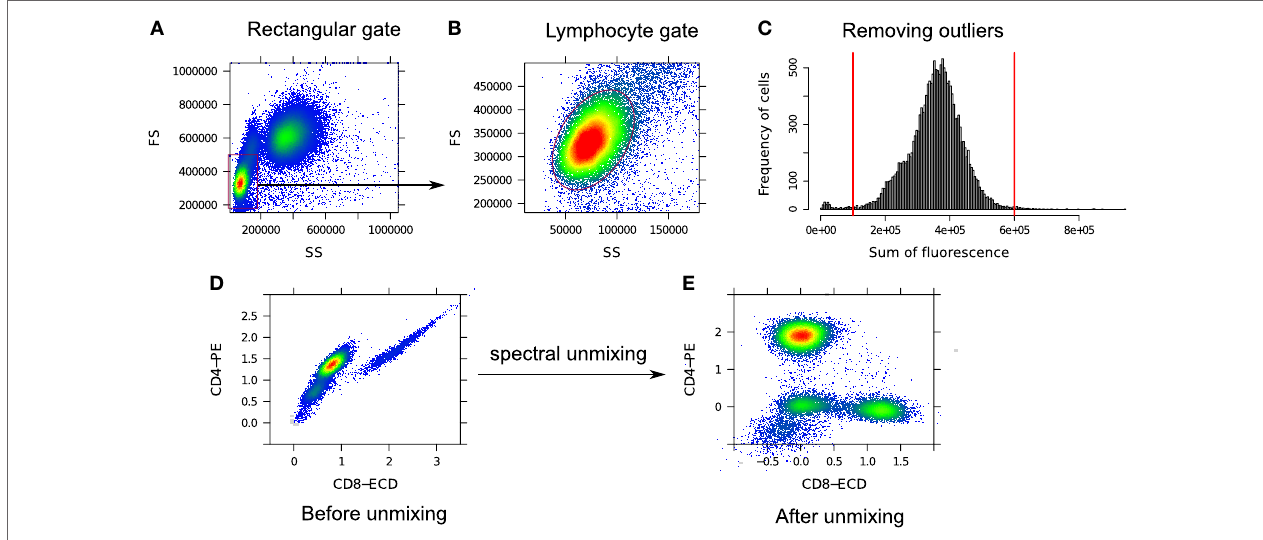
FigUre 5 | (a) A predefined rectangular gate (red rectangle on the lower left corner) denotes an approximate boundary for the lymphocytes. (B) Inside the rectangular gate, lymphocytes are identified as a dense and normally distributed region (red ellipse). (c) Outlying cells fall outside of a pair of predefined thresholds shown with the red vertical lines and are removed. (D) Correlated CD4 and CD8 expressions due to the spectral overlap between PE and ECD fluorochromes. (e) CD8 vs. CD4 expressions after spectral unmixing. The inverse hyperbolic sine (asinh) transformation is used in (D,e) for visualization.